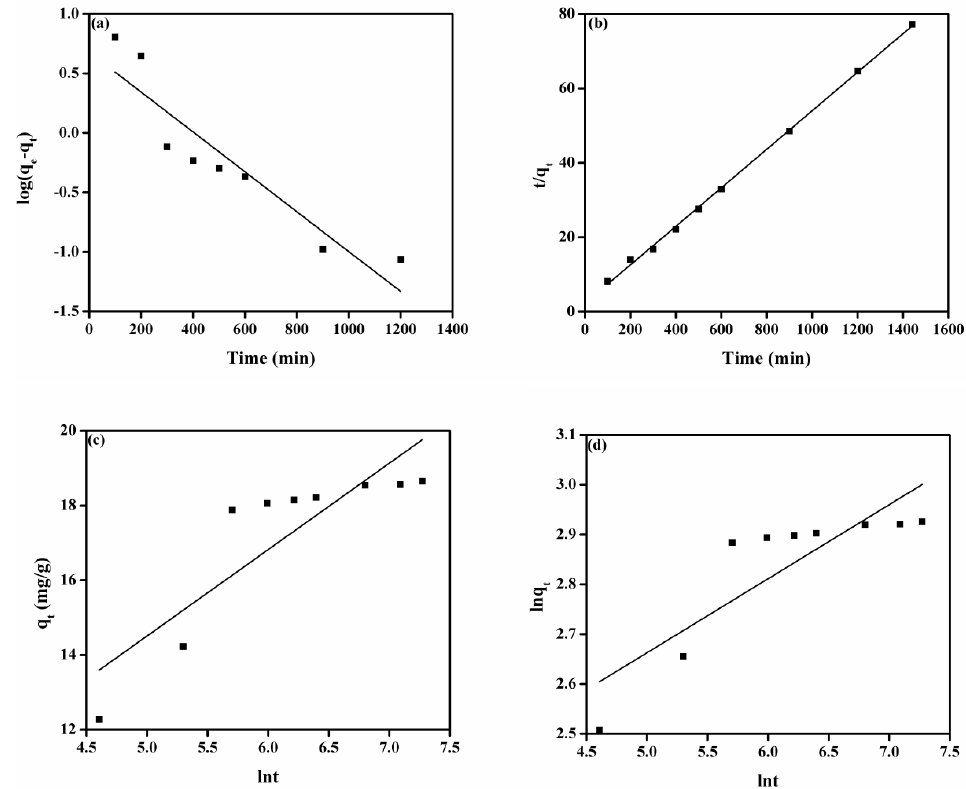
Figure 5. ( a ) Pseudo-first-order model, ( b ) pseudo-second model, ( c ) Elovich model, and ( d ) modified Freundlich equation for the adsorption of MO onto the DMEA-grafted AEM. Table 2. Calculated values of kinetic equation rate constants represent that adsorption of MO followed pseudo-second-order model. Kinetic Models